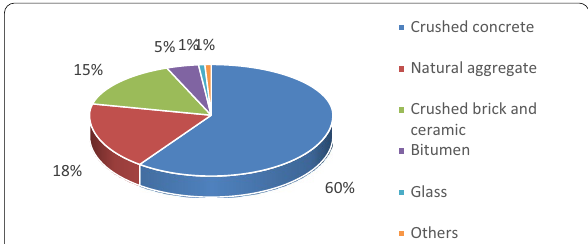
Fig. 1 Composition of the recycled aggregate used in this research